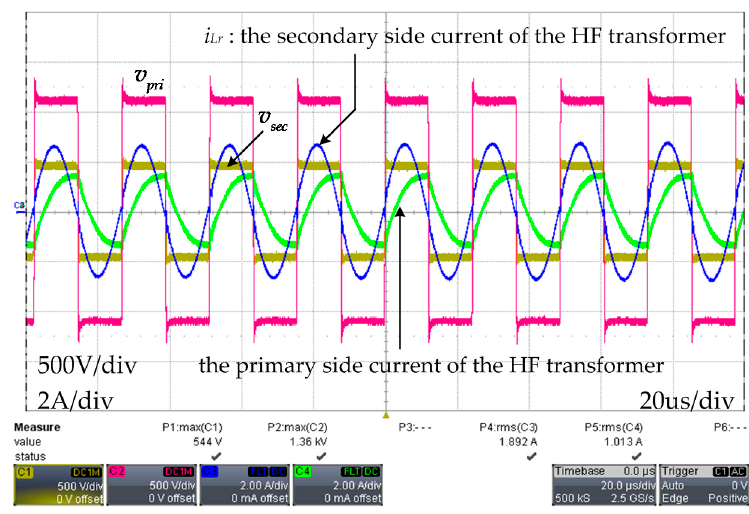
Figure 22. Experimental waveforms of an LLC resonant converter.